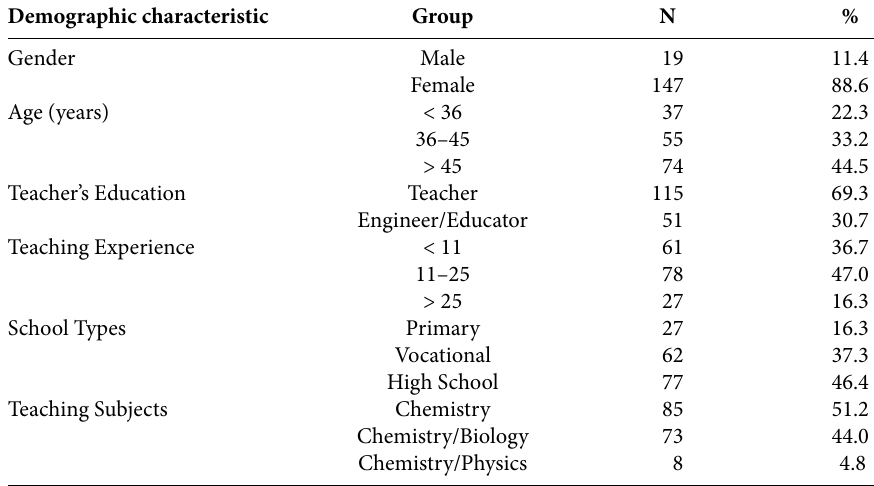
Table 1. Description of Participants’ Demographic Characteristics (N = 166) by Groups Demographic